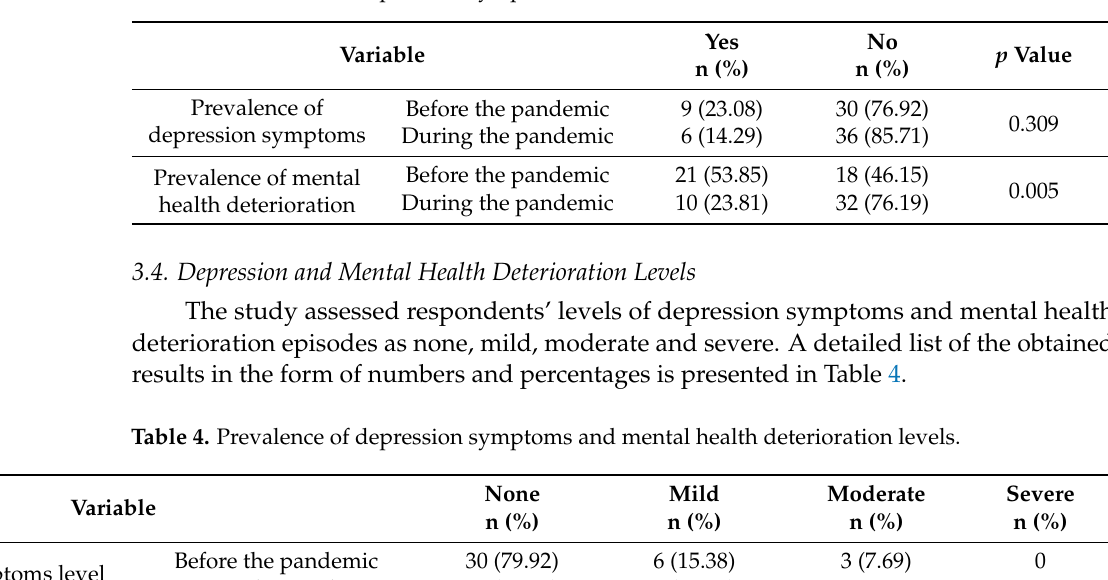
Table 3. Prevalence of depression symptoms and mental health deteriorations.